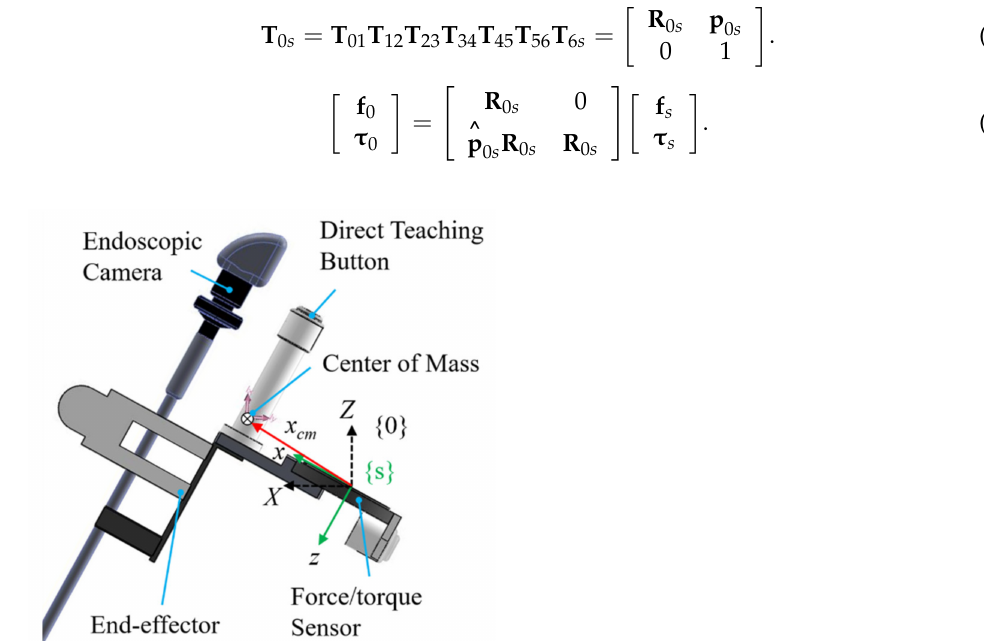
Figure 4. End-effector and sensor with moving frame and position vector of the center of mass. Gravity-induced torque is measured on the sensor as the position of the center of gravity changes depending on the posture. It can be obtained in the robot base coordinate as shown in Equation (10). The position vector, x cm , from the sensor to the center of mass of the end-effector is [106 mm, 0 mm, − 12 mm] T . The mass, m , is 1.01 kg, and the